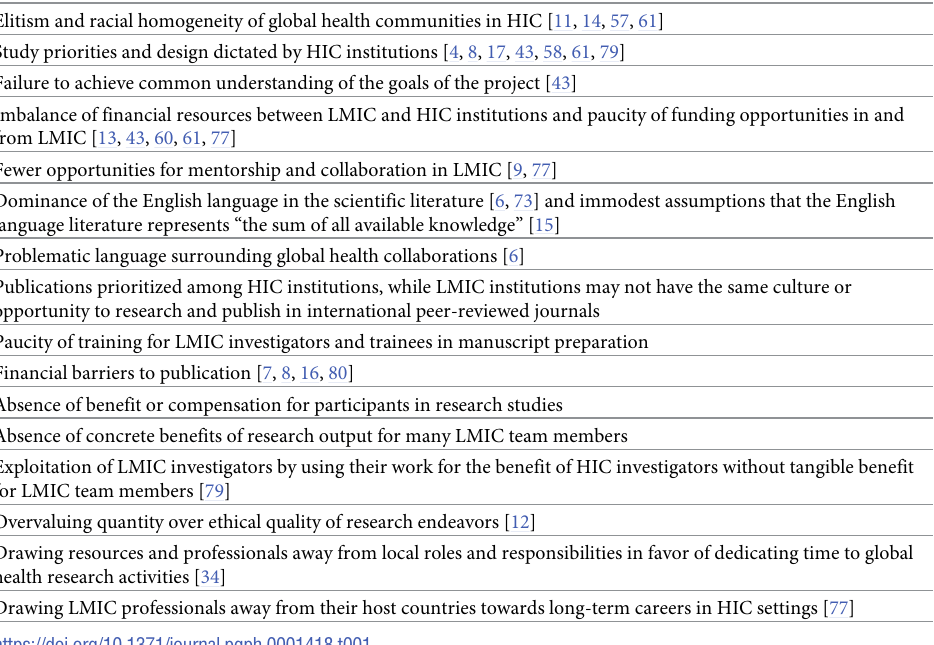
Table 1. Current problems with global health research and